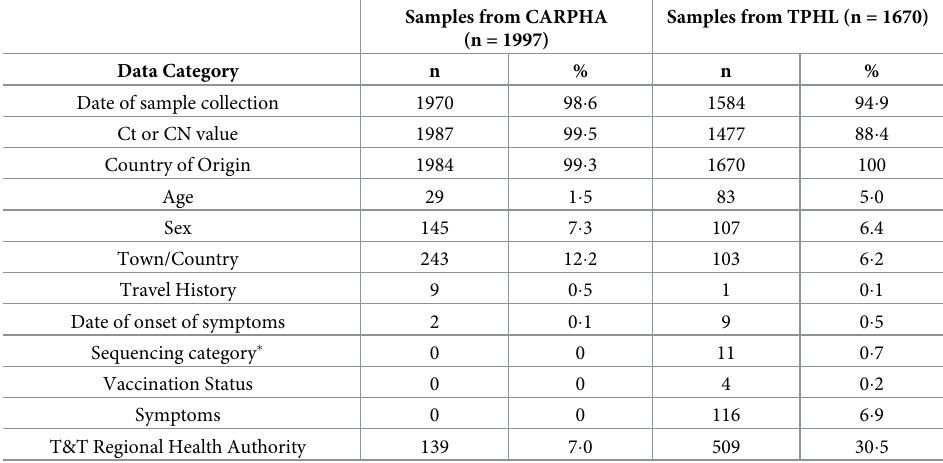
Table 1. Sample metadata retrieved from SARS-CoV-2 sequencing requisition forms and sending institution rec- ords for samples received during the period 5 th Dec 2020 to 31 st Dec 2021. Samples from CARPHA (n =